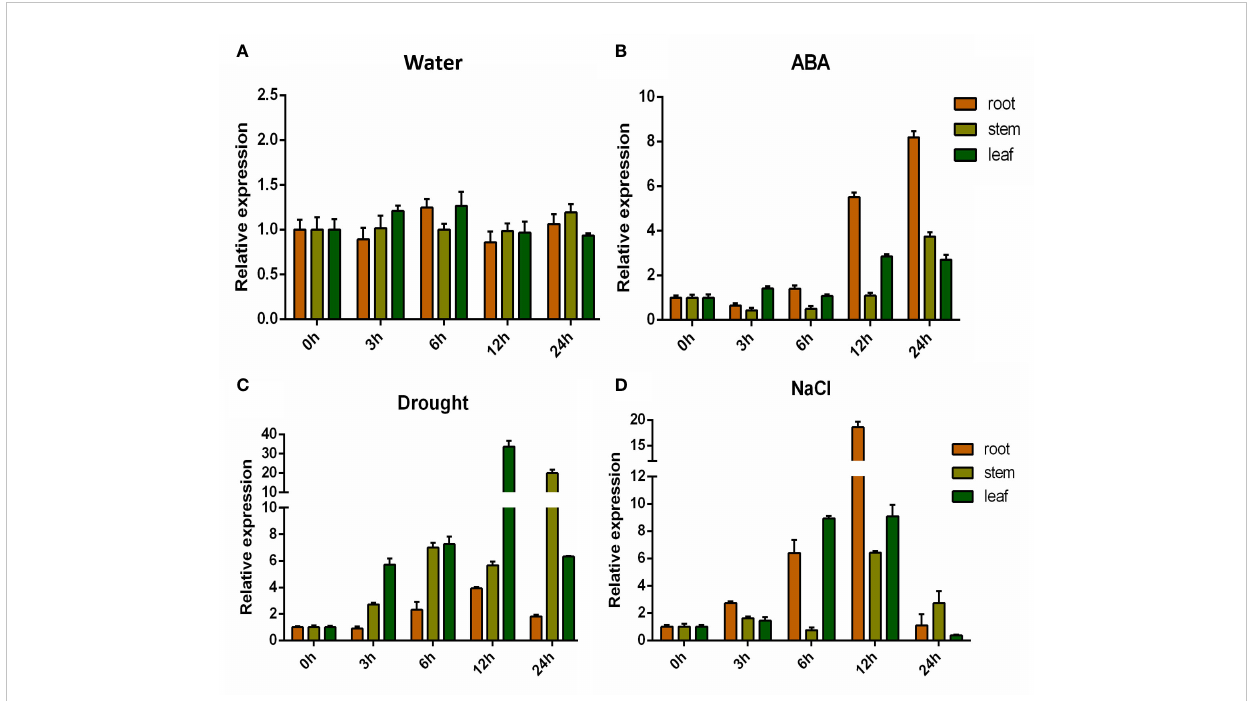
FIGURE 7 Expression pattern of GhHVA22E1D . Expression pattern of GhHVA22E1D in G hirsutum after 500 m M ABA (B) , 10% PEG6000 (C) and 250 mM NaCl (D) stresses, and the water treatment group was the control (A) . Each sample was sampled at 0, 3, 6, 12, and 24 h after treatment. The results are the meanof three